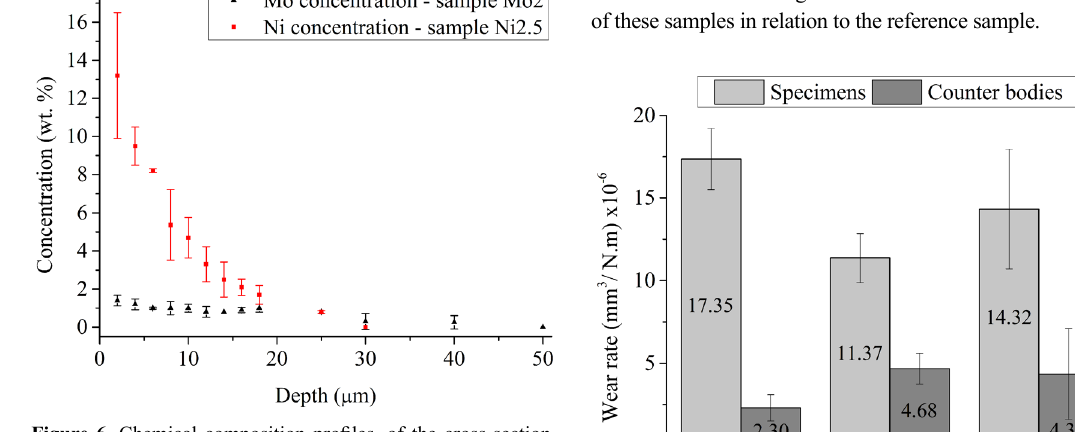
Figure 6. Chemical composition profiles, of the cross-section, obtained by EDX. For the Mo2 sample the profile remained practically constant in the first 10 μm. The error bars means the standard deviation of the chemical composition.